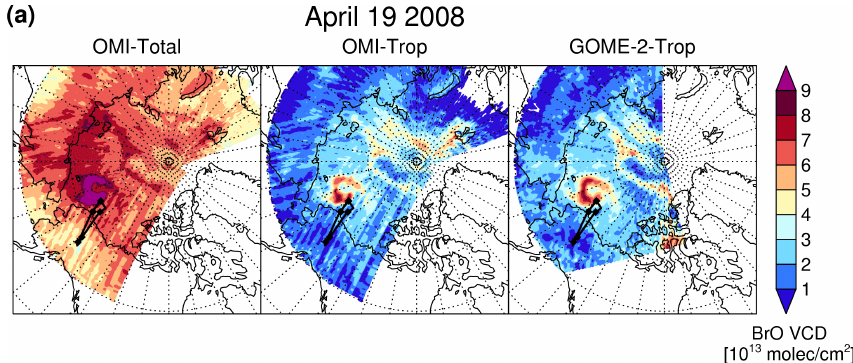
Fig. 9a. Similar to Fig. 7a but for the WP-3D flight of 19 April 2008. (b)